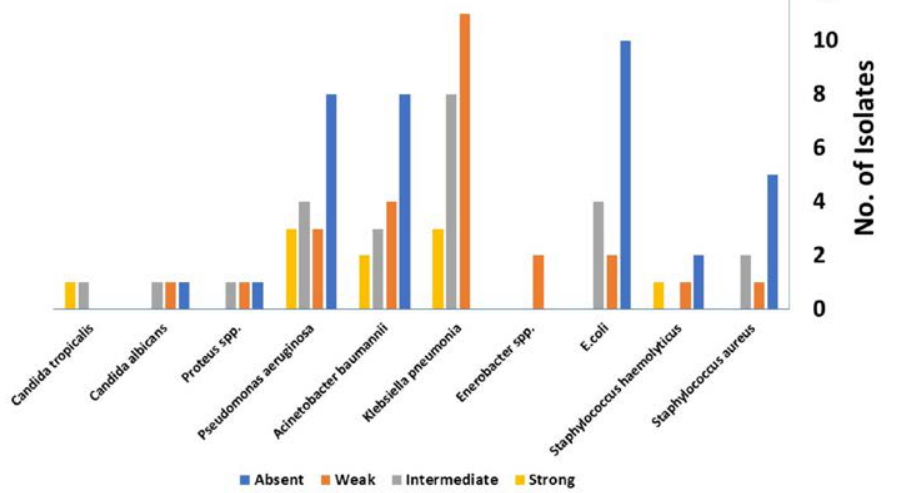
Fig. 1. Biofilm forming ability of clinical isolates recovered from different nosocomial clinical